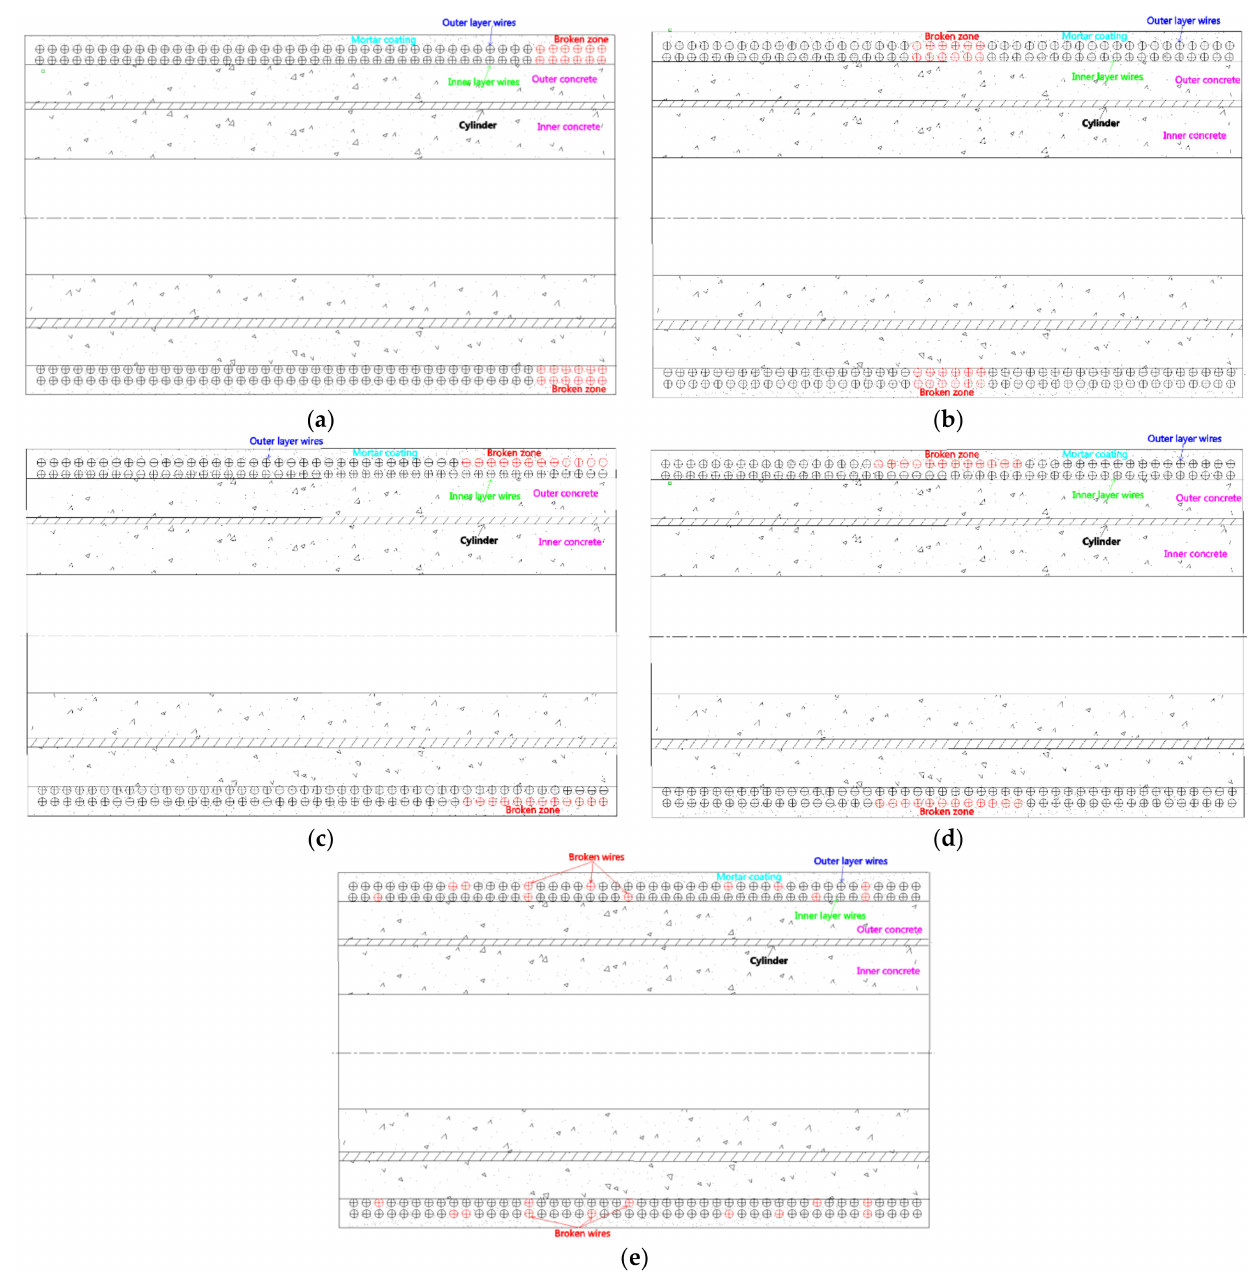
Figure 4. Location of broken wires: ( a ) two layers at joint, ( b ) two layers at middle, ( c ) outer layer at joint, ( d ) outer layer at middle, ( e ) random